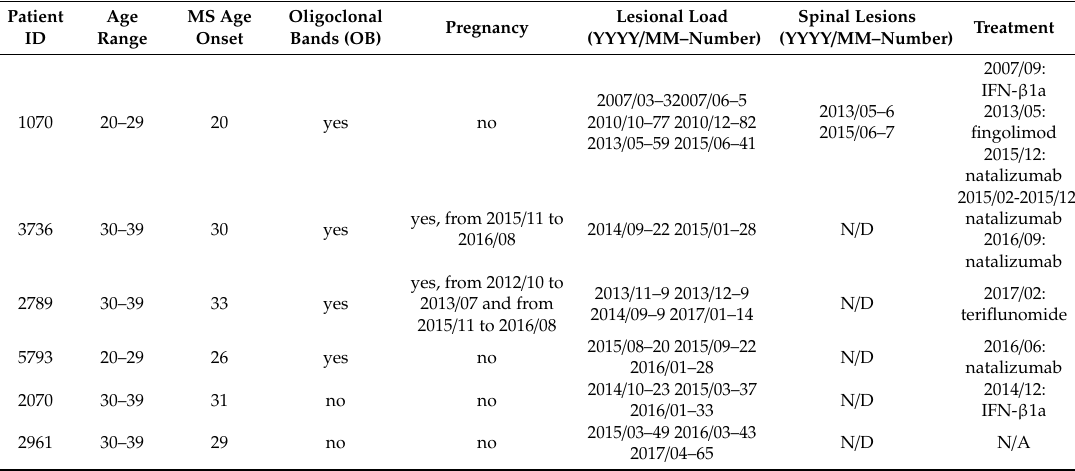
Table 2. Patients data summary. The table shows, for each patient, the clinical information that we translated into simulation terms to reproduce and predict the MS